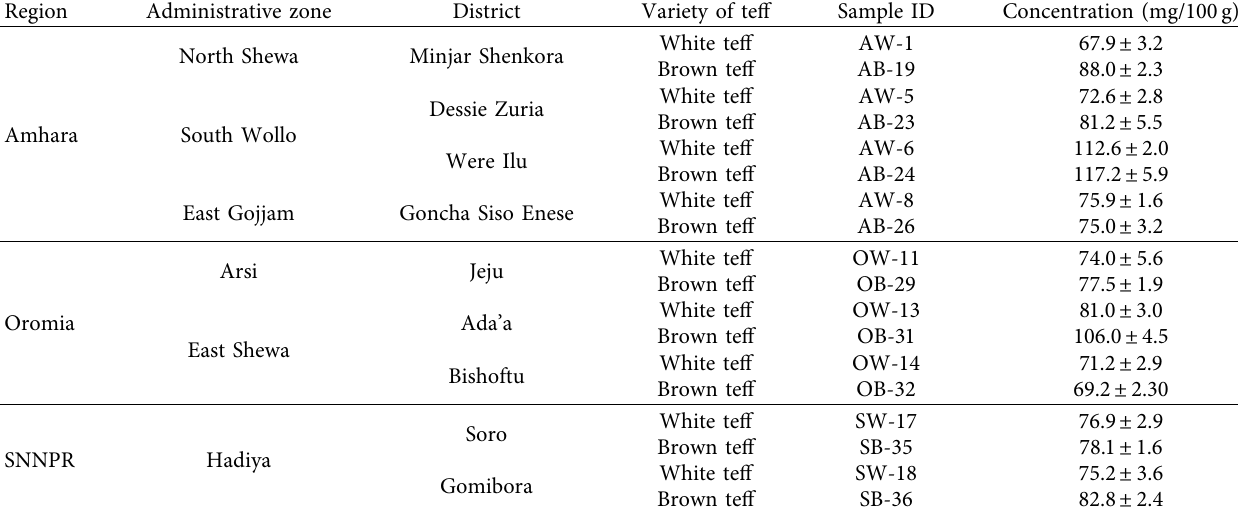
Table 1: Ascorbic acid content (mean ± SD) of the white and brown tef [ Eragrostis tef (Zuccagni) Trotter] grains determined by iodimetric titration.